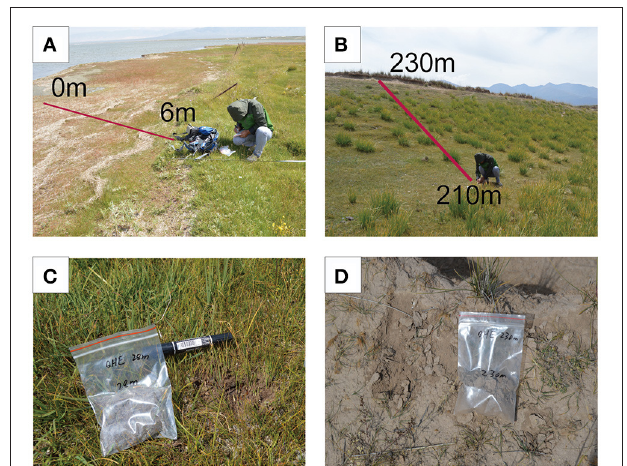
FIGURE 2 | Field photographs of the offshore soils of Lake Qinghai. (A) the lake edge; (B) the slop between 210m and 230m; (C) the wet grassland sample at 28m; (D) the dry grassland sample at